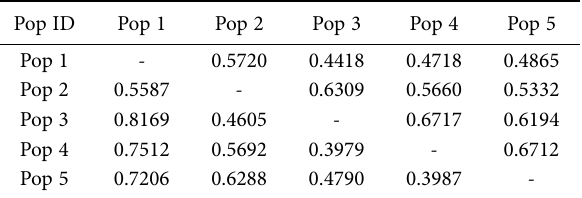
Table 5 Nei’s genetic identity (above diagonal) and genetic distance (below diagonal) between different populations.